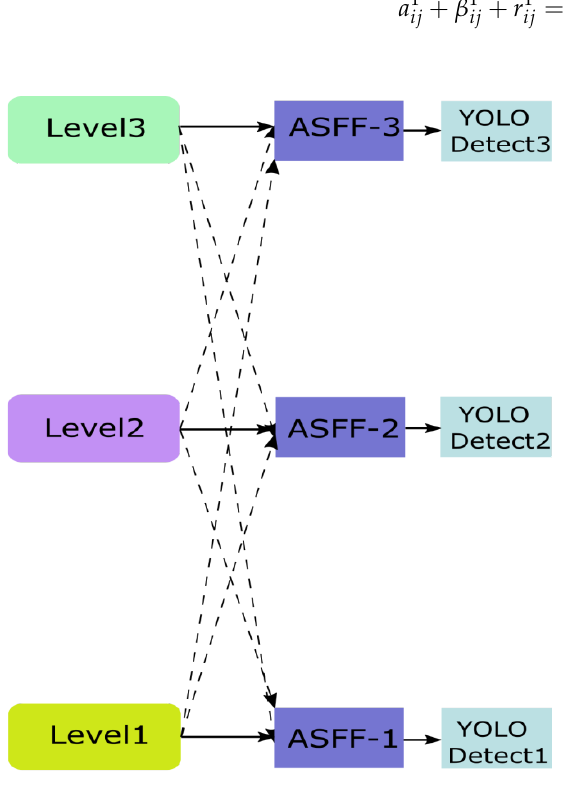
Figure 6. Schematic diagram of adaptively spatial feature fusion.